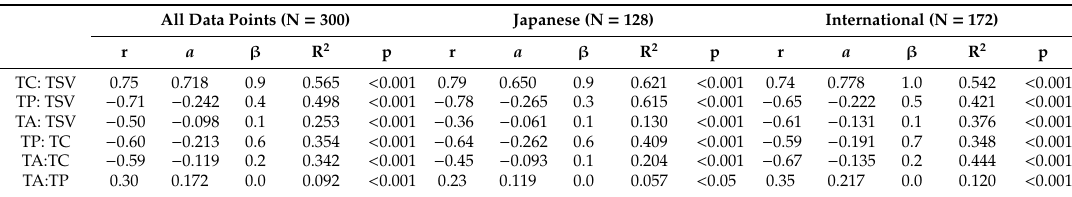
Figure 10. The frequency distributions and correlation between thermal responses; ( a ) Distribution of TC; ( b ) correlation TP: TSV.